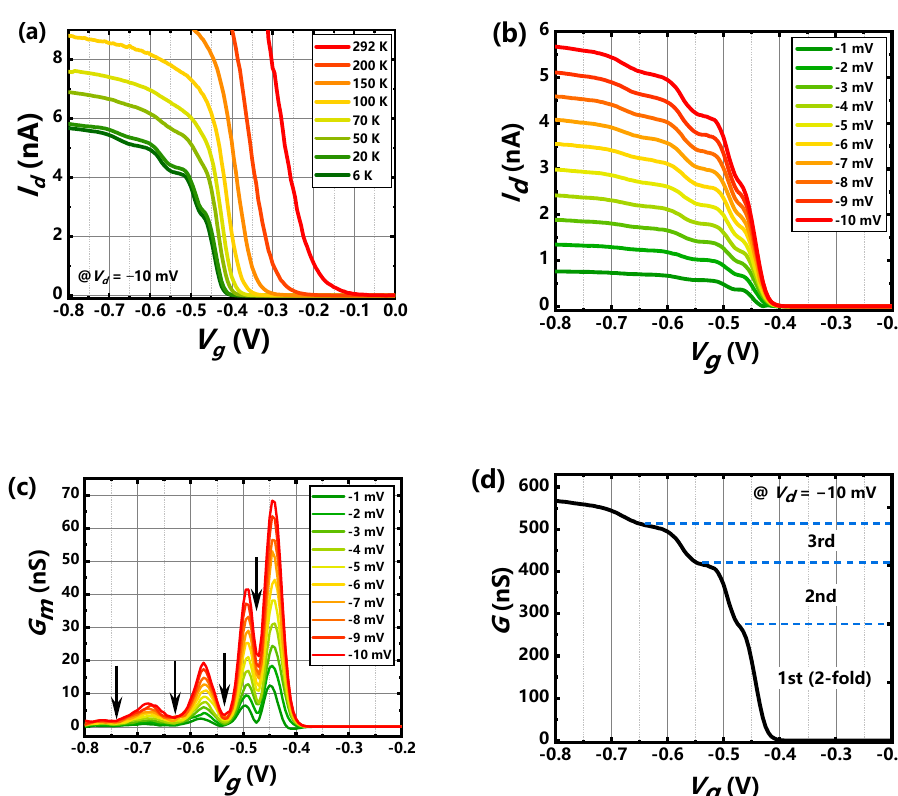
Figure 5. ( a ) Measured I d – V g curves at V d = − 10 mV within the temperature ranging from 6 K to 292 K. ( b ) Measured I d – V g curves at different drain voltage at 6 K. ( c ) Transconductance extracted from ( b ). ( d ) The conductance as function of gate voltage for V d = − 10 mV at 6 K.